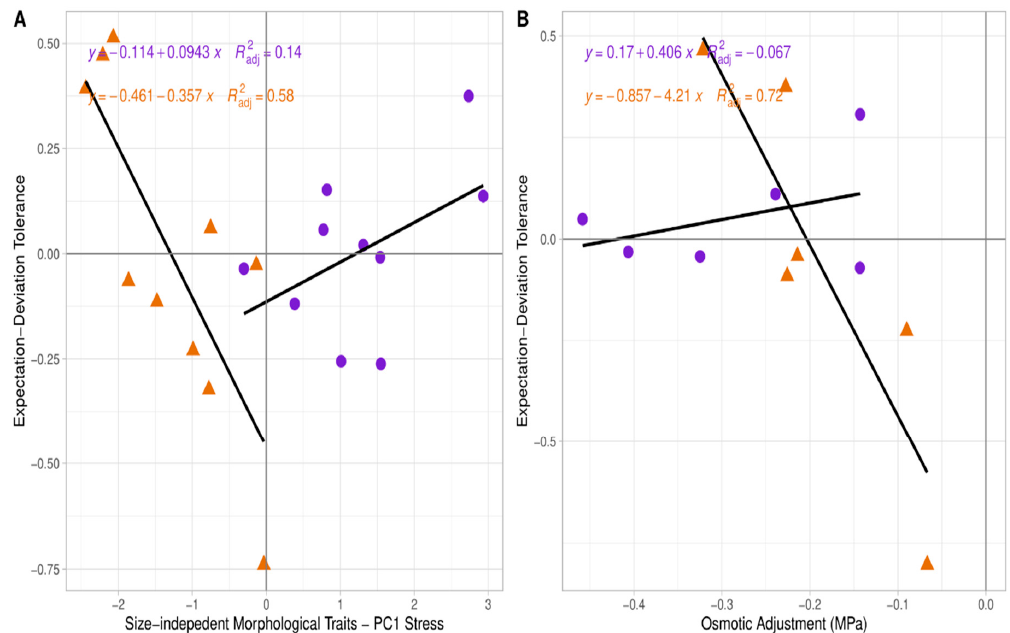
Figure 5. The relationships between expectation-deviation tolerance metric and ( A ) size-independent morphological traits PC1 under stress, or ( B ) osmotic adjustment (OA). Purple circles indicate cultivated accessions and orange triangles indicate wild